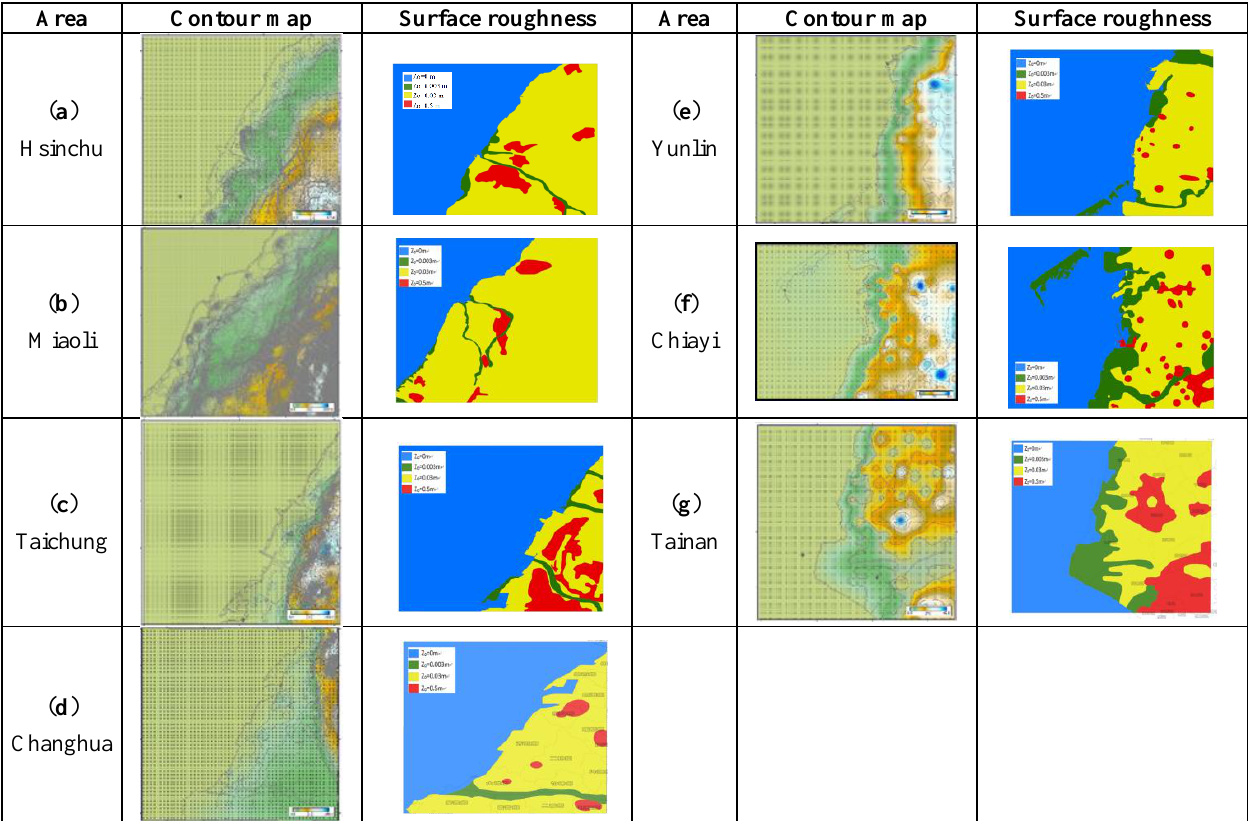
Figure 6. Developmental offshore wind farm in western Taiwan.